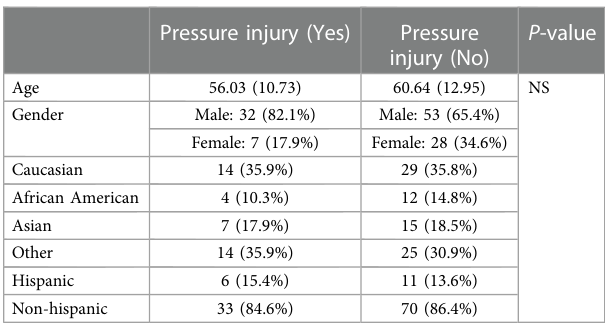
TABLE 1 Clinical and demographics variables of patients.